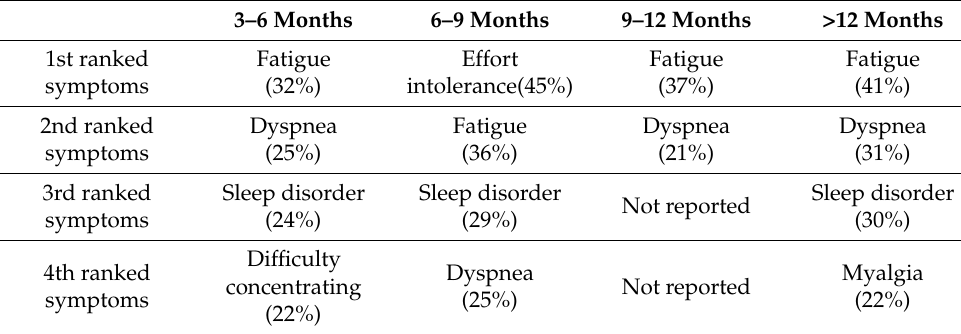
Figure 3. Clinical Follow-up Schedule of PC19S. Patients are recommended to have an initial clinical assessment at the time of discharge and follow-up for at least 3 months for persistent symp- toms/patients with high-risk factors. Patients with persistence/progression of symptoms beyond 9 months should consider specialist referral as most symptoms disappear by 9 months. Triple assess- ment is recommended based on clinical, radiological and biochemical assessment for a comprehensive review. Rehabilitation programs are provided to patients, stratified by clinical severity to optimize resource usage and rehabilitation progress [8]. Table 4. Prevalence of PC19S symptoms at different follow-up periods